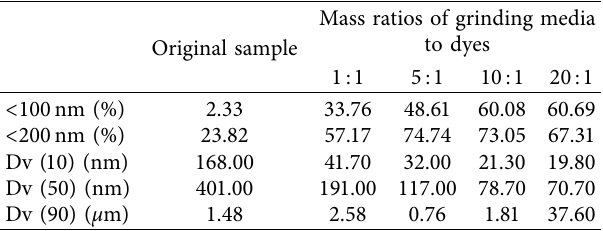
Table 3: Particle sizes of dispersed orange 31 with diferent mass ratios of grinding media to dyes.